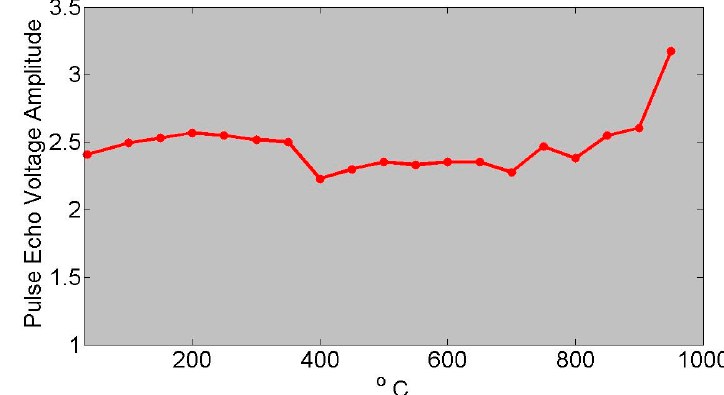
Figure 3. Ultrasonic high-temperature performance of single-crystal AlN wafer on steel cylinder showing acceptable performance to about 950 °C [2].